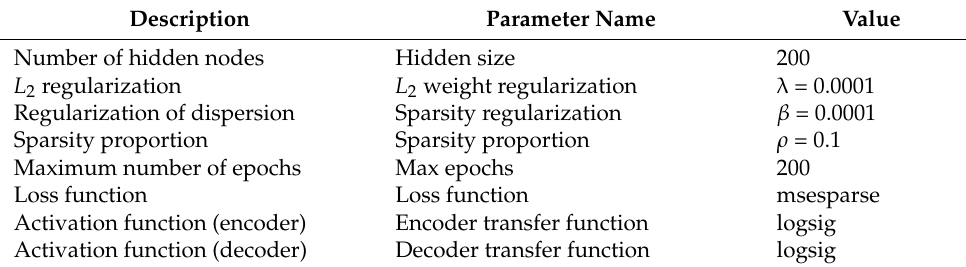
Table 7. Training parameters for the autoencoder detector.